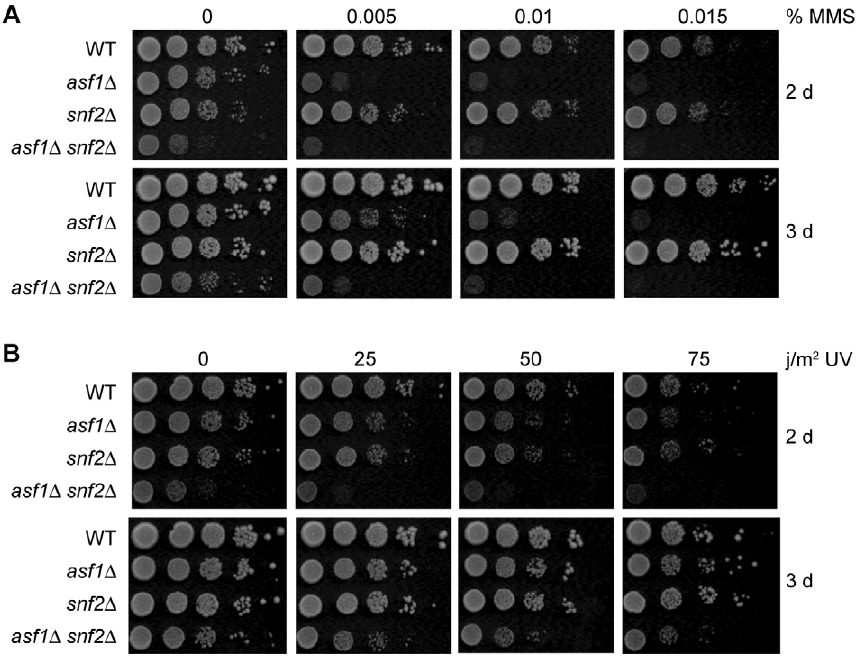
Figure 6. asf1 D snf2 D mutants are sensitive to genotoxins that cause chemical modification of DNA. A. asf1 D snf2 D double mutants are sensitive to MMS. Ten-fold serial dilutions of early log phase cells were spotted onto rich medium with or without MMS and grown at 30 u C. Photographs were taken after 2 and 3 days. B. asf1 D snf2 D double mutants are sensitive to UV irradiation. Ten-fold serial dilutions of cells were spotted onto rich medium and irradiated or not. Plates were incubated in the dark at 30 u C and photographed as in (A).